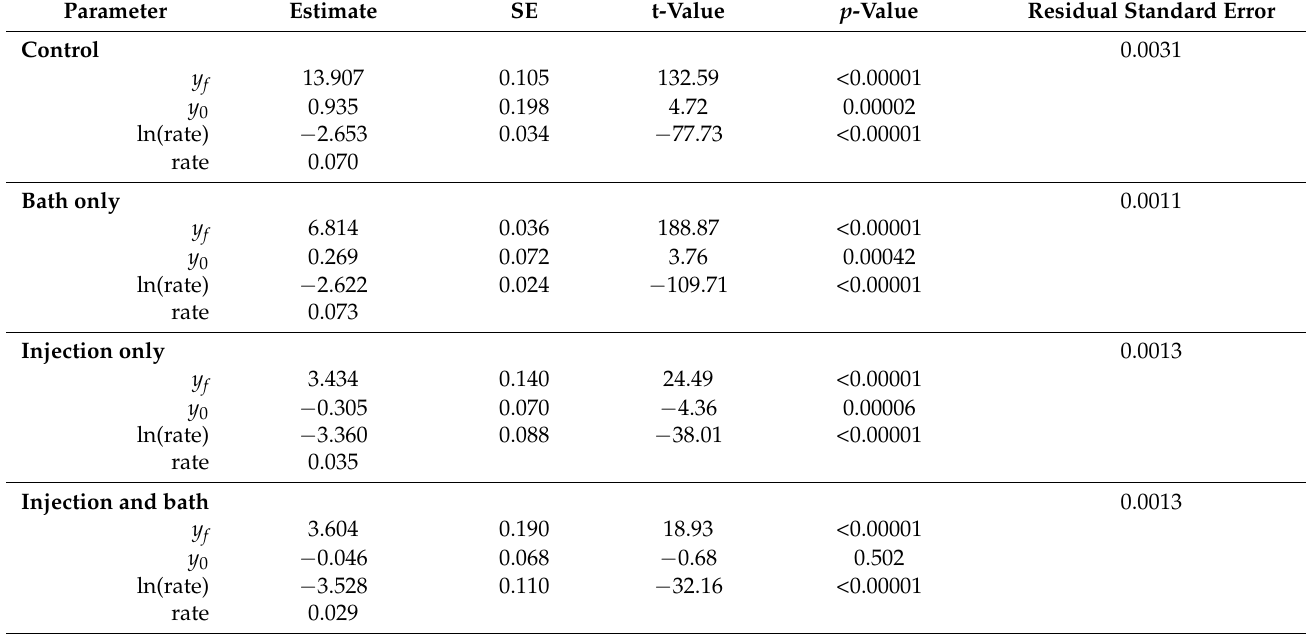
Table 1. Model parameters from function to estimate mortality (%) within each treatment. y 0 is the initial mortality on day 0; all treatments were very close to zero initial mortality. Ln(rate) and rate describe the steepness of the mortality curve in our models, expressed both as the model uses it (natural log of rate) and back-transformed to simply a rate for ease of interpretation (rate); y f is the asymptote of cumulative mortality. Each model was fit to the daily mortality from that treatment ( n = 56, model df = 53), and total residual standard error of the model is in the last